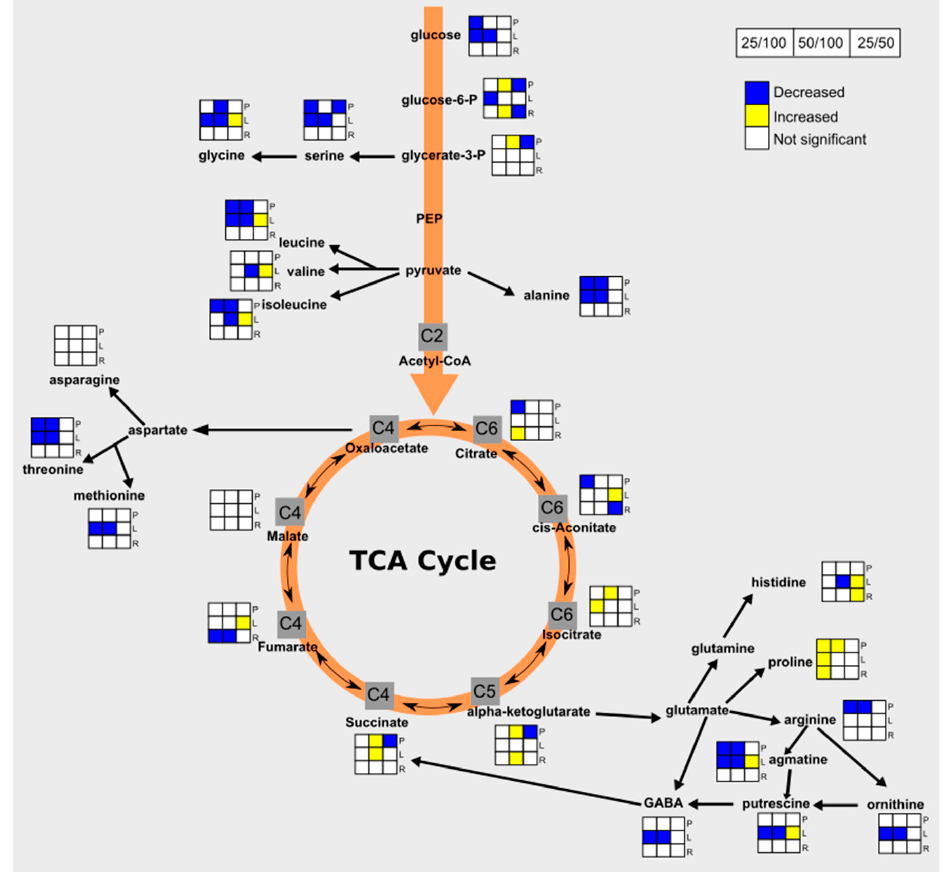
Figure 6. Metabolic changes in TCA cycle and amino acid pathways induced by water treatments in S. viridis organs. For each metabolite, a colored table is shown, with rows representing the plant organs (P—panicles; L—leaves; R—roots) and columns representing pairwise treatment comparison (from left to right: 25/100, 50/100, 25/50). Blue indicates significant level decrease, yellow indicates significant level increase and white means no significance in the comparison. Statistical significance was determined by ANOVA followed by Tukey’s test ( p < 0.05 ).